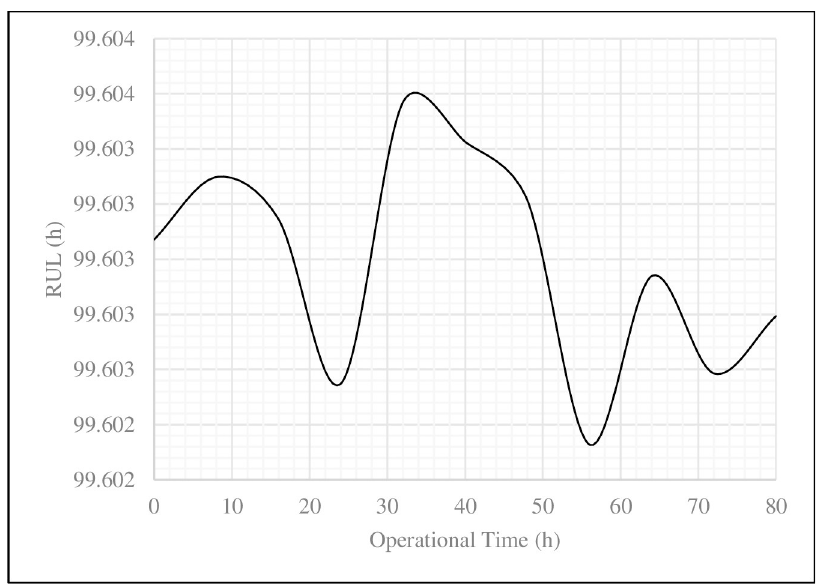
Fig 5. The plot of RUL values during 80 operational hours of the excavator in the classical-exponential model.